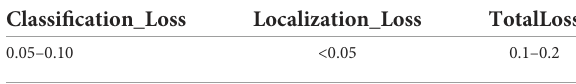
TABLE 1 iNaturalist species-trained models training loss value.